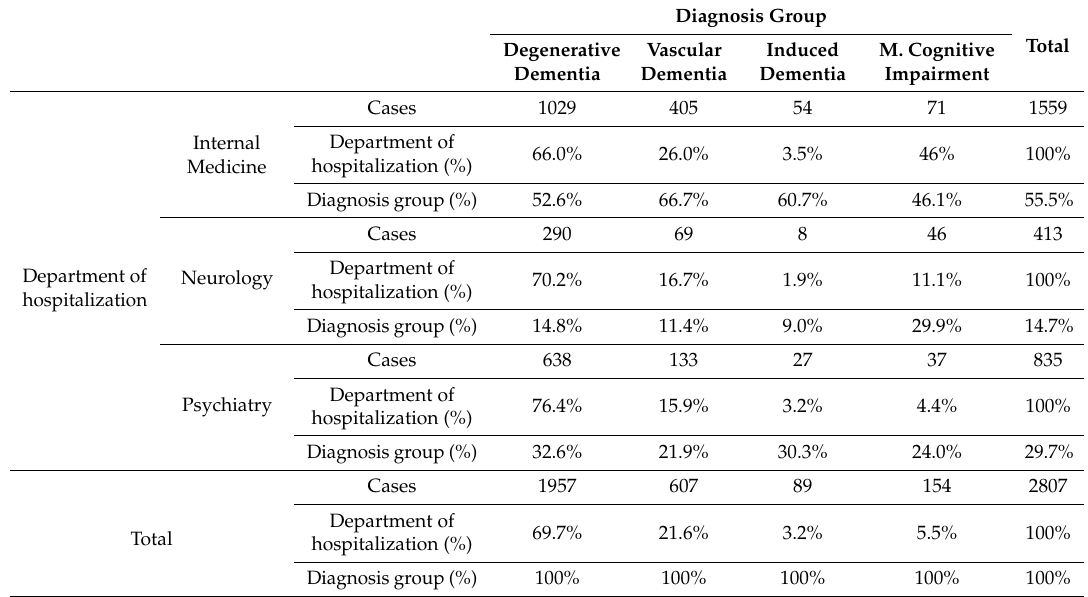
Table 3. Department of hospitalization by diagnosis